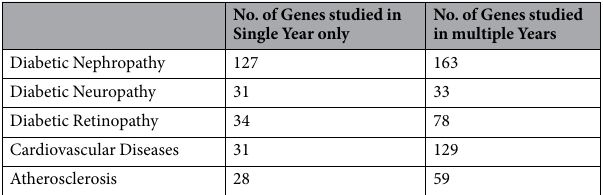
Table 1. Number of Genes studied in a single year or in multiple years in T2DM